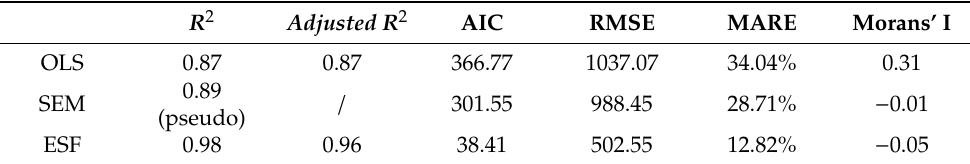
Table A6. Model performance of vcmsl version NTL data in 2015.